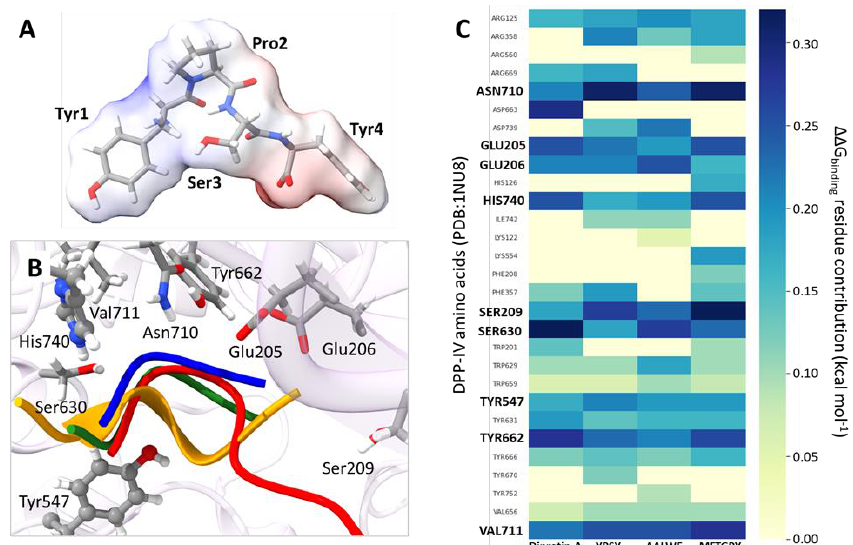
Figure 4. Molecular interactions between DPP-IV and pajuro peptides after model structure refinement. ( A ) Representation of the YPSY peptide at physiological pH and its electrostatic potential isosurface showing negatively and positively charged regions in red and blue, respectively. ( B ) Side view (bottom) of the DPP-IV pocket to illustrate the occupancy by pajuro peptides. For pajuro peptides, only the backbone chain is shown; chains with blue color correspond to YPSY peptide, orange to AALWE peptide, orange chains to MFTGPY peptide, and green chains to diprotin A inhibitor. The figure also explicitly shows side chains of residues with higher contribution to ∆ G binding according to in silico alanine scanning. ( C ) Heat map showing the ∆ G binding contributions of DPP-IV residues to their binding to pajuro peptides according to in silico alanine scanning using DRUGSCOREPPI web server based on a knowledge-based scoring function. The name of residues with higher contributions are bold